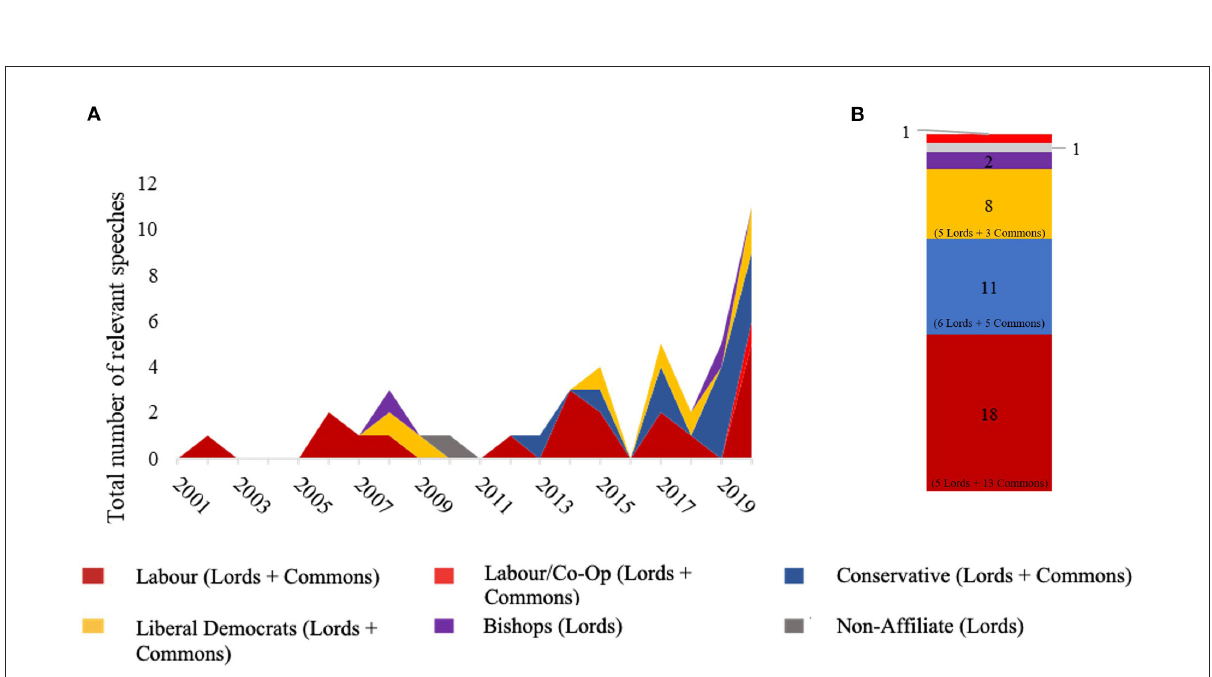
FIGURE3 (A) Increase in frequency of speeches on the links between mental health and climate change with political breakdown and (B) total number of speeches by political party across the 20 years (01/01/2001–31/12/2020). The analysis includes only speeches where direct links between mental health and climate change were mentioned ( N =